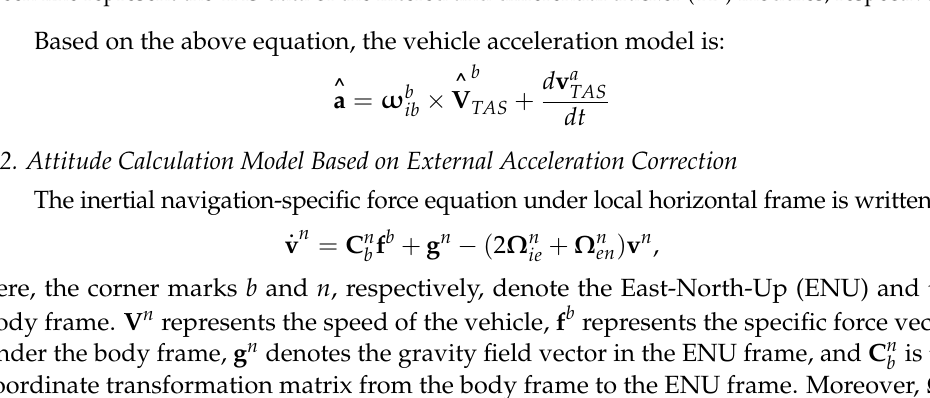
Figure 2. The comparisons between the true airspeed (TAS) measured by pilot tube and the ground velocity measured by RTK. The orange line shows the original signal of TAS. The red line and the green line represent the TAS data of the filtered and differential tracker (TD) modules, respectively.